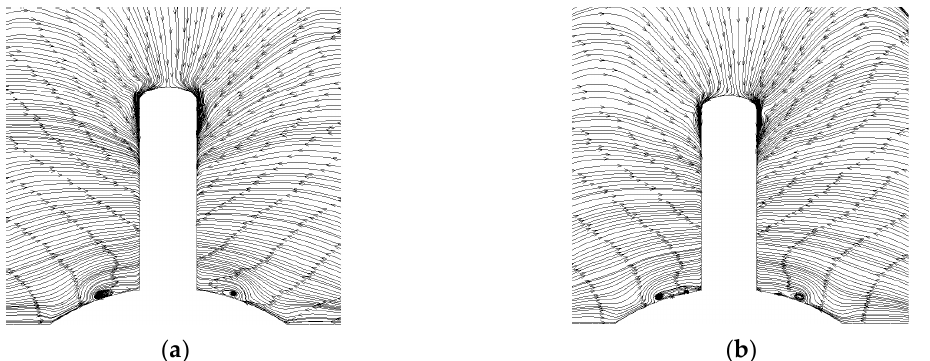
Figure 10. The streamlines at Plane C of the two models. ( a ) The original model; ( b ) The model with leading-edge serrations.